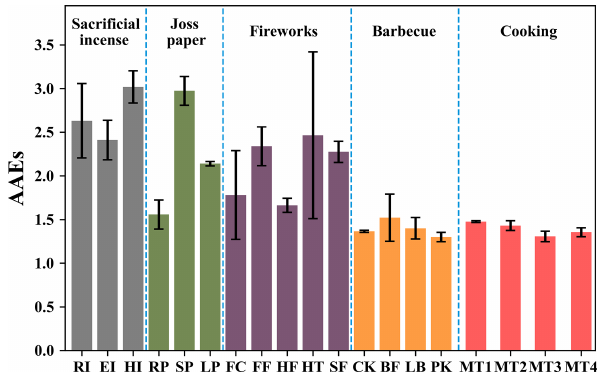
Figure 2. The absorption Ångström exponents (AAEs; 370– 880nm) of the